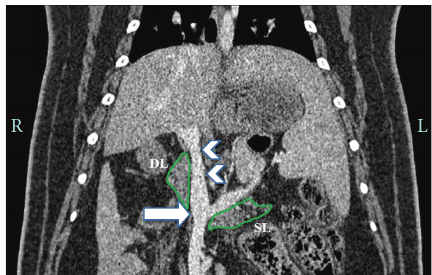
Figure 1: Preinterventional planning CT angiography. Coronal CT angiogram demonstrating the normal vascular anatomy of the por- tal venous system. Note the splenoportal confluence (arrow) and the long extra-hepatic course of the portal vein (arrowheads) in relation to the pancreatic duodenal lobe (DL) and the splenic lobe (SL). Both pancreas lobes are outlined in